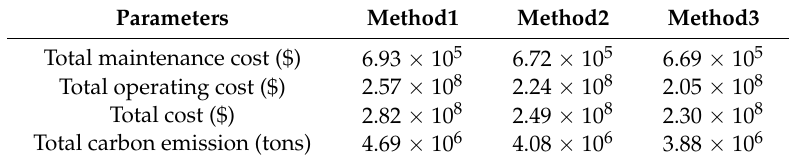
Table 7. Total cost and total CO 2 emissions in a 20-year planning period using the three